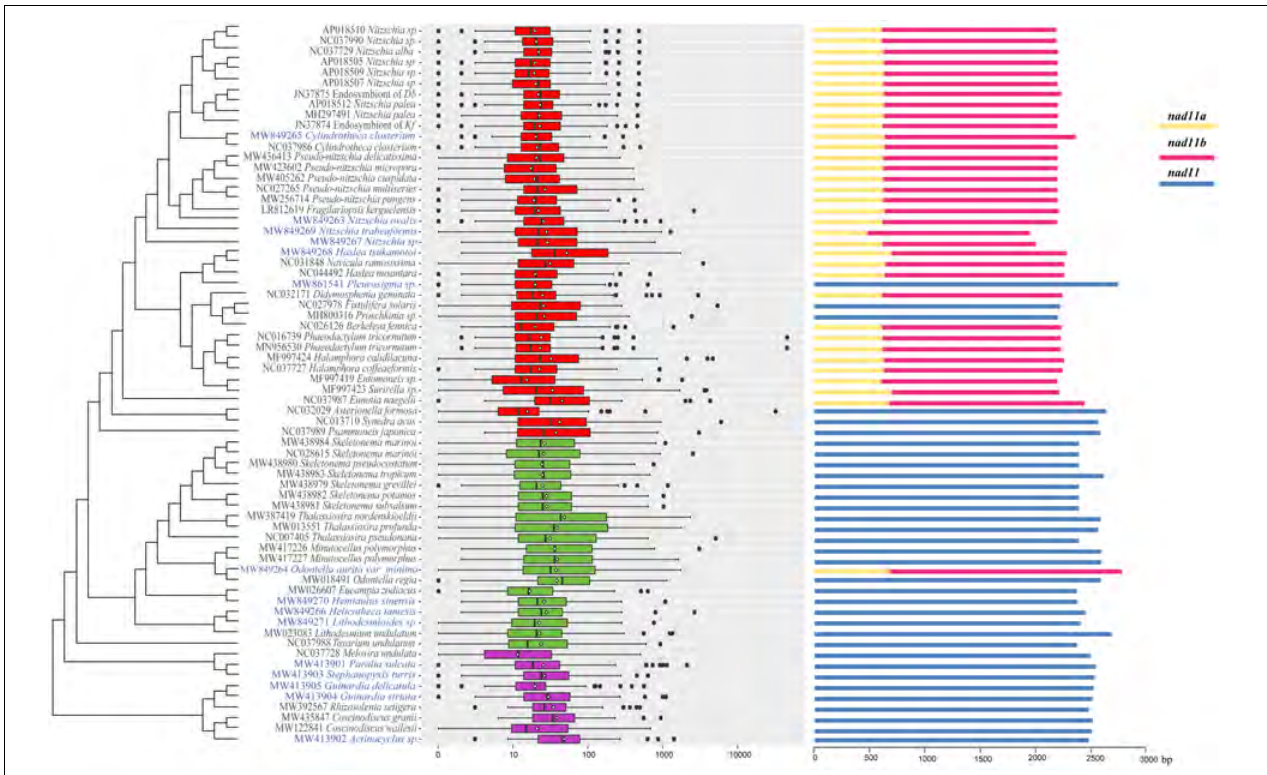
FIGURE 6 | Boxplot of intergenic region length and the structure of nad11gene of 68 mtDNAs. On the left part, red boxes, green boxes, and purple boxes represented the three classes Bacillariophyceae, Mediophyceae, and Coscinodiscophyceae, respectively. The white point and black vertical line of every box were average and median of intergenic region length, respectively. The scale of intergenic region length is in a log10 units. On the right part, nad11a and nad11b were two unit caused by the break of the nad11 gene.